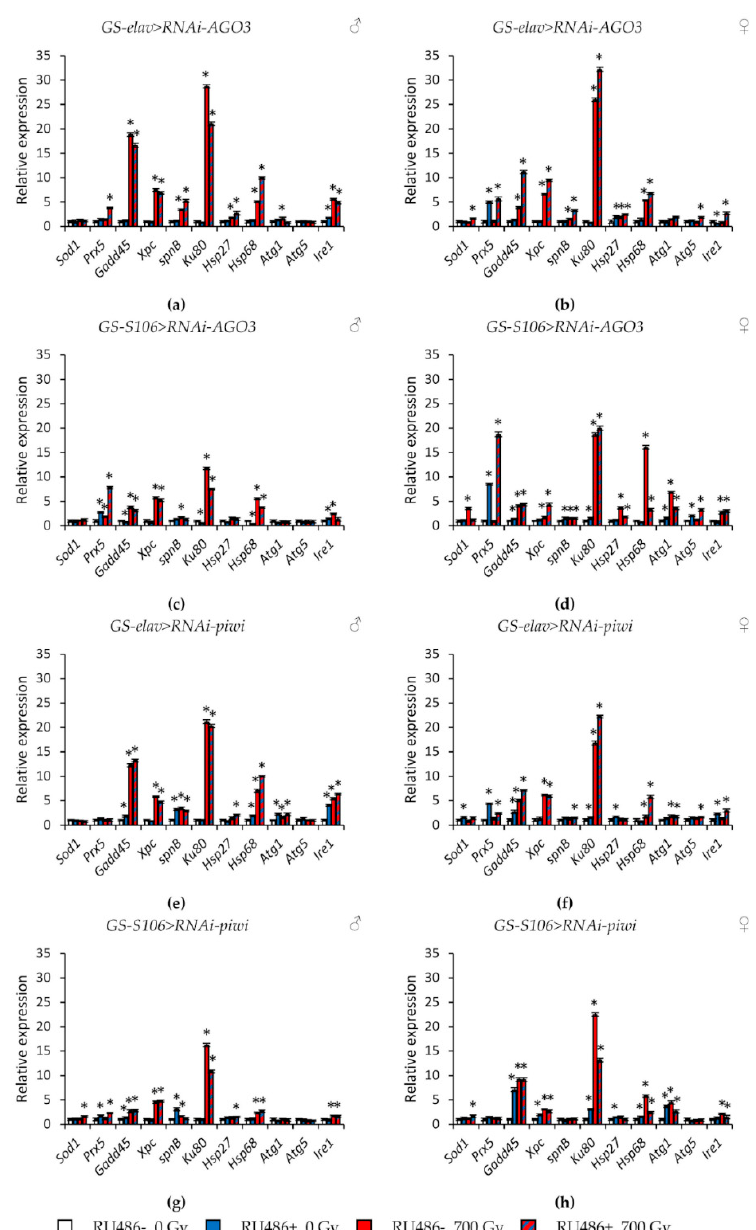
Figure 8. Changes in the expression of stress response genes in irradiated and unirradiated males ( a , c , e , g ) and females ( b , d , f , h ) with AGO3 ( a – d ) and piwi ( e – h ) knockdown. Differences between relative expression levels of the investigated genes of unirradiated flies without PIWI genes’ knockdown (RU486-, 0Gy) and each of other experimental variants are statistically significant with * p < 0.05 (Mann-Whitney U-test).